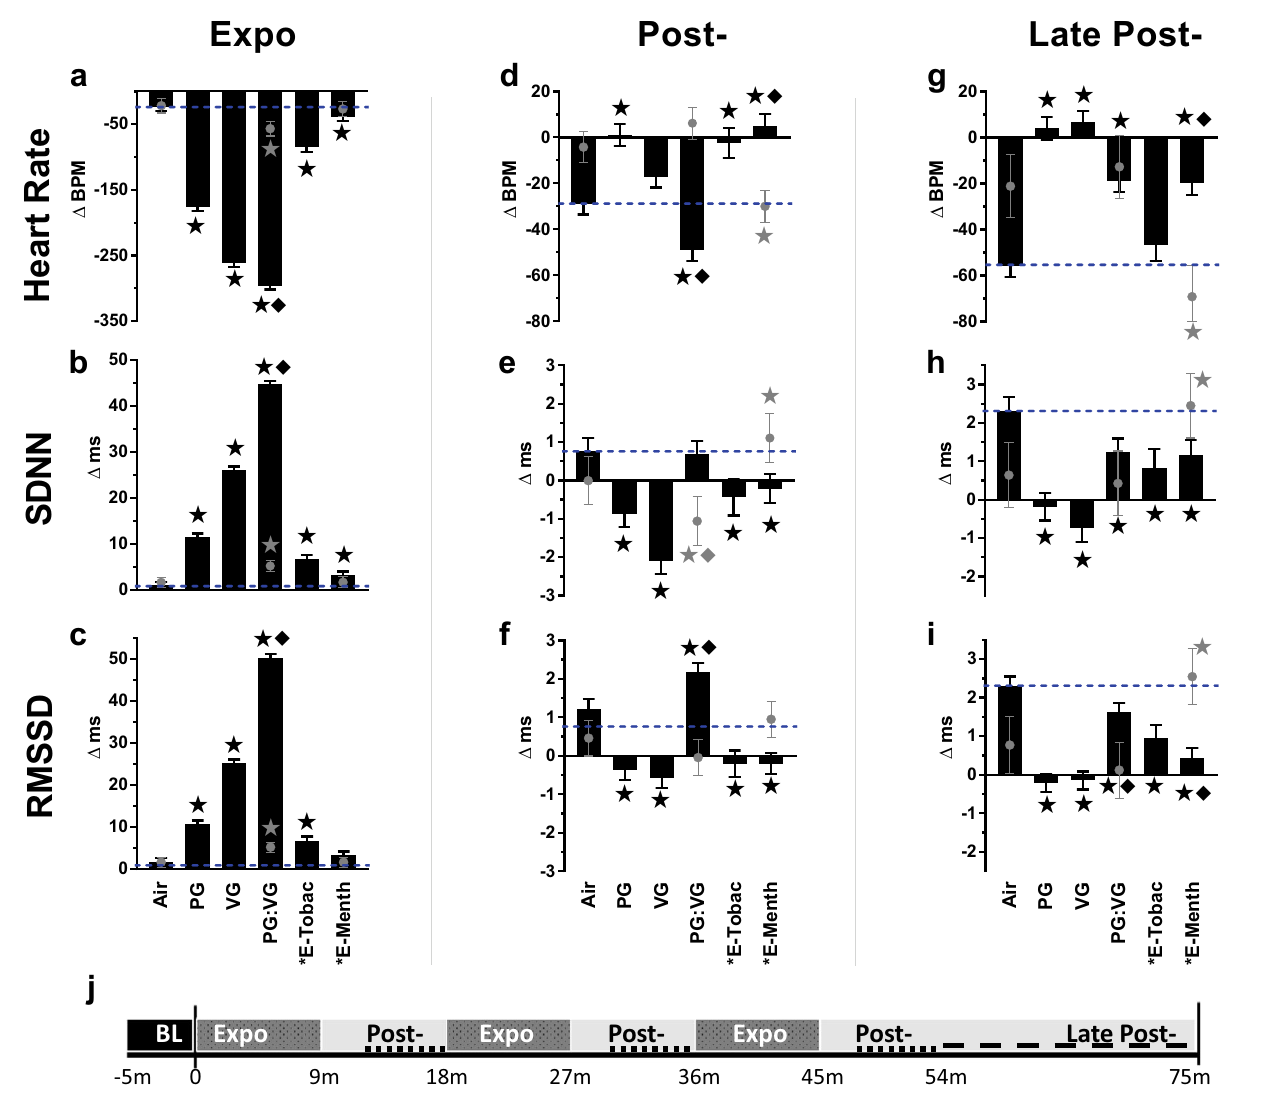
Fig. 2 | Inhalation exposure to E-cig aerosols alters heart rate and heart rate variability (HRV). Bars (males) or gray circles (females) represent least square means (±SEM) of change from 5-min baseline in heart rate and HRV (SDNN and RMSSD)atdifferentexposurephases( a – i ),andindicatedbystudytimeline( j )with Expo denoting puff sessions, Post- denoting 4 – 9min after each puff session, and Late Post- indicating 9 – 28min after the fi nal puff session. Dashed lines mark Air mean. Signi fi cance determined by two-sided P <0.05 (vs. Air: star; between sexes: